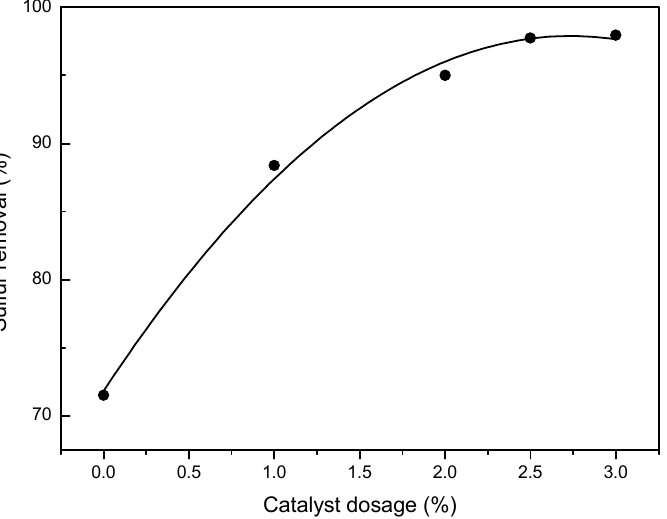
Figure 7. The effect of catalyst dosage on DBT removal. Experimental conditions: initial sulfur concentration, 500 ppm; temperature, 0 °C; ozone dosage, 0.1 g/h; reaction time, 60 min.